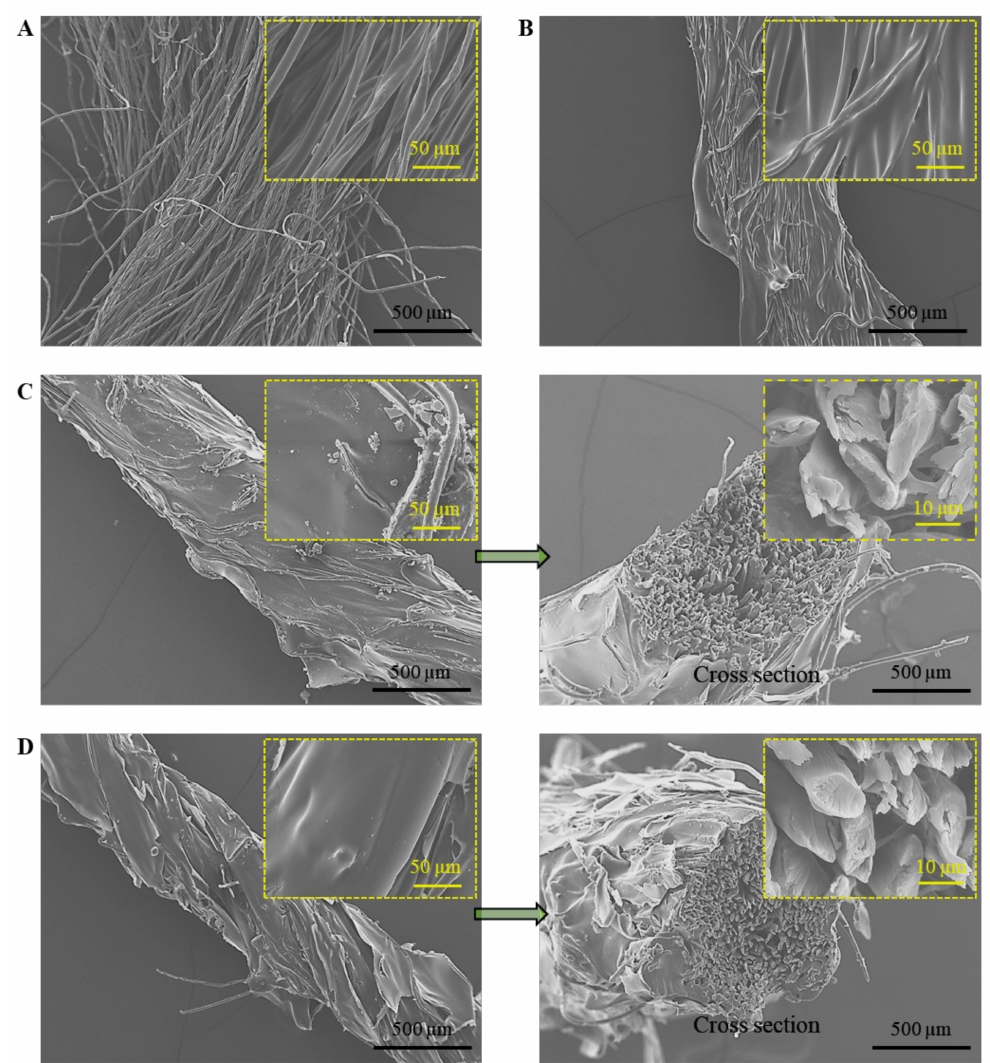
Figure 3. SEM images of gel/fibre composite actuators (insets show high-magnification images): ( A ) As-received multifilament cotton fibre; ( B ) PEPU coated untwisted fibre; ( C ) PEPU and alginate coated untwisted fibre; ( D ) gel/fibre twisted actuator (left side image showing surface morphology and right side image showing cross section of the twisted